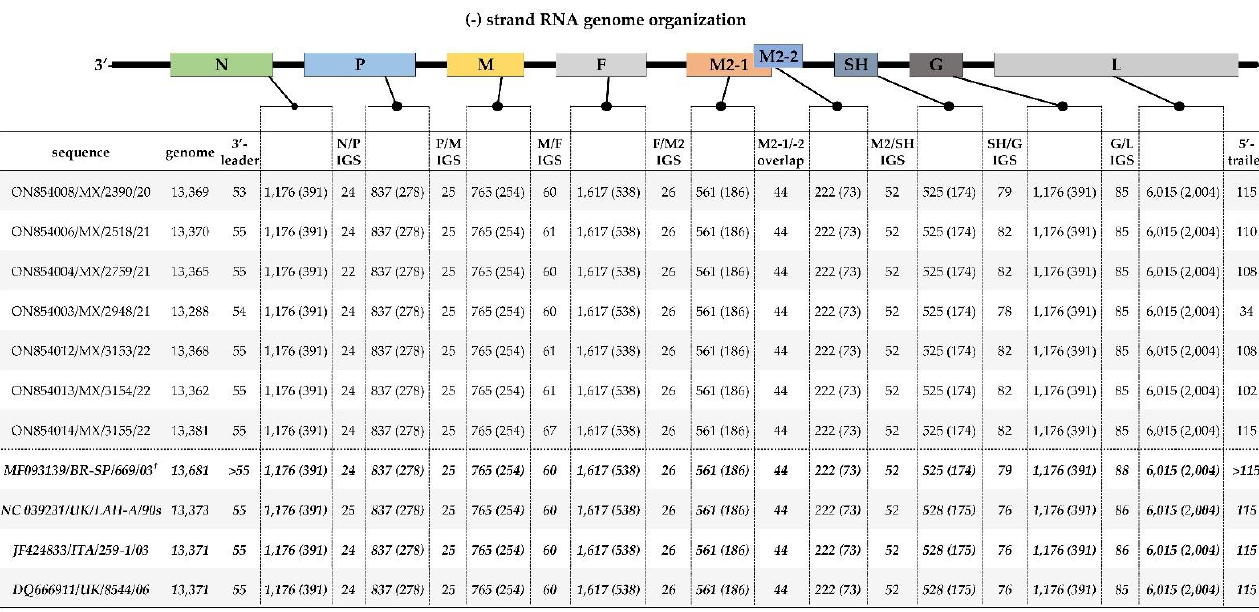
Figure 1. Genome organization and sequence lengths (nt and deduced amino acid (aa) residues (in brackets; excluding the final stop codon)) of the CDS and non-coding intergenic sequences (IGS) between adjacent genes of the seven complete genome sequences of aMPVs identified in the current study compared to previously reported Eurasian and Brazilian aMPV-A strains (four sequences shown at the bottom of the Figure in italicized bold font). Isolate/strain names include GenBank accession number, avian species , country, and year of sample collection. † strain BR -SP/669 has extended 3′ -leader ( n = 186 nt) and 5′ -trailer ( n = 291) regions.